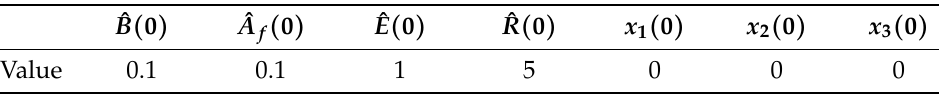
Table 2. The settings of the initial values.